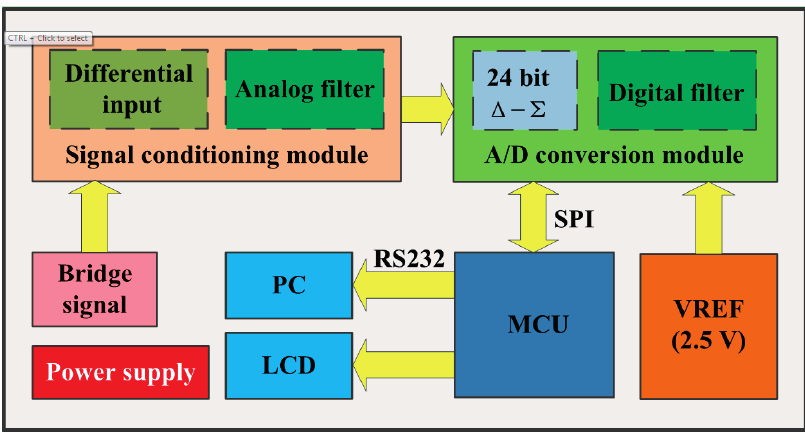
Figure 5. Structure of data acquisition